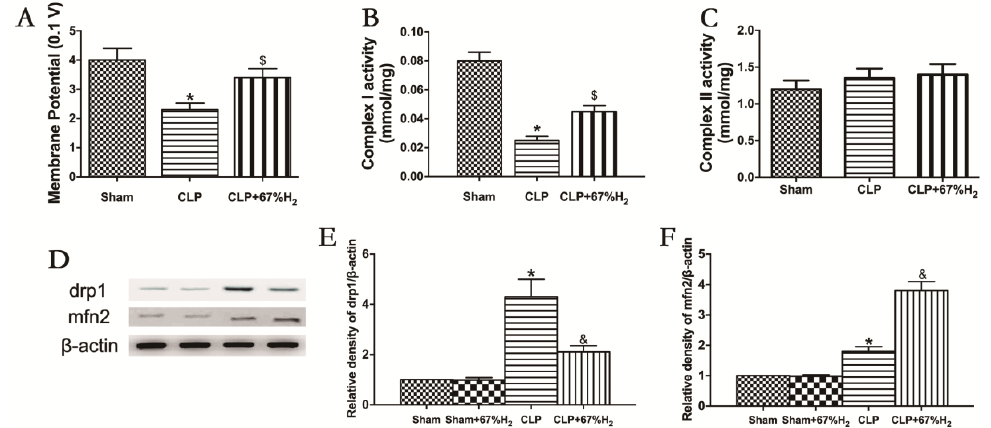
Figure 6. H 2 ameliorated sepsis-induced mitochondrial dysfunction. ( A ) MMP; ( B ) Complex I activity; ( C ) Complex II activity; ( D ) The expression of Drp1 and Mfn2 was detected by Western blot analysis; quantitative analysis of ( E ) Drp1 and ( F ) Mfn2 are presented as the ratio of band density to that of β -actin. Data were output as mean ± SD ( n = 6). * p < 0.05 vs. Sham group. $ p < 0.05 vs. CLP group. & p < 0.05 vs. CLP group.